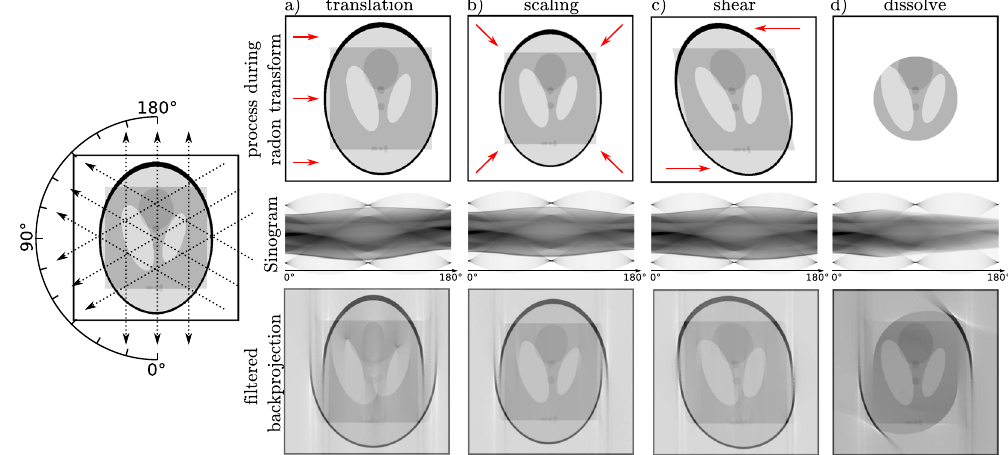
Figure 1. Illustration of artefacts induced by motion and dynamic processes during a tomographic measurement. The starting point t = 0 for each simulated measurement was the image depicted on the left side with a size of 512 2 pixels. Notice that the black frame is a part of the object but only the inner Shepp-Logan phantom and the rectangle were modified while the object was projected from 0° to 180° at a constant rate. The inner part was ( a ) linearly translated, ( b ) scaled with a linear decrease of the scaling factor, ( c ) sheared linearly and ( d ) ‘dissolved’ by multiplying a mask with linearly shrinking radius. The images in the upper row show the maximum change at the end of the tomographic scan. Each of the corresponding sinograms depicted in the middle row consists of 804 equidistant projections to satisfy angular sampling. Common filtered backprojections of the sinogram data are depicted in the bottom row. They show pronounced artefacts originating from the motion, like false shapes, missing features and non-closed circles. Vertical ‘streaks’ in the 0° and 180° direction are clearly visible in each reconstruction, since temporal and thus structural differences are largest for the corresponding